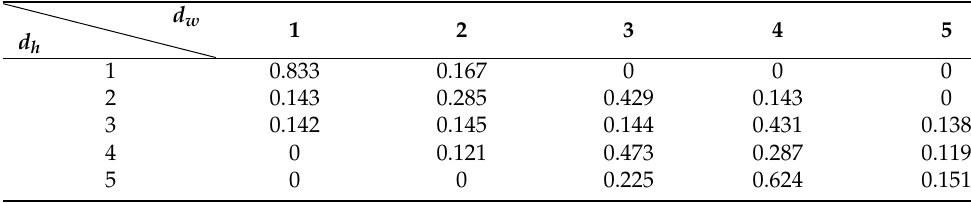
Table 10. Conditional probability distribution P ( d w | d h ) of node d h .